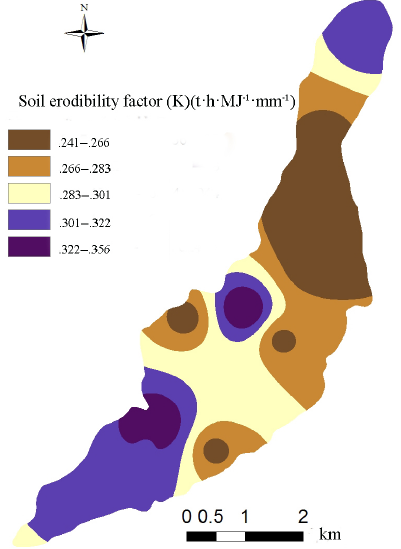
Figure 5. Soil erodibility map ( K ).